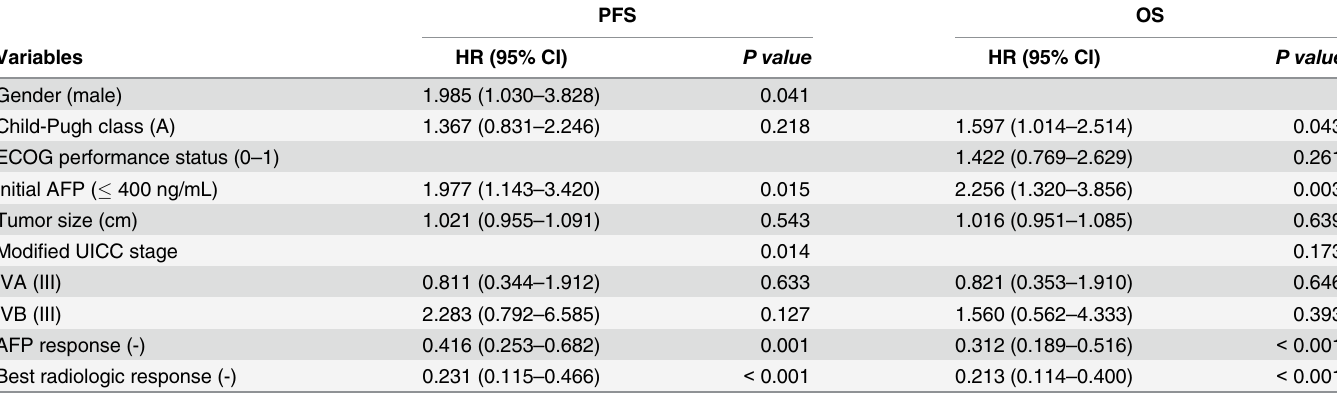
Table 3. Multivariate analysis for progression-free survival (PFS) and overall survival (OS) rates in the propensity score-matching cohort. PFS OS